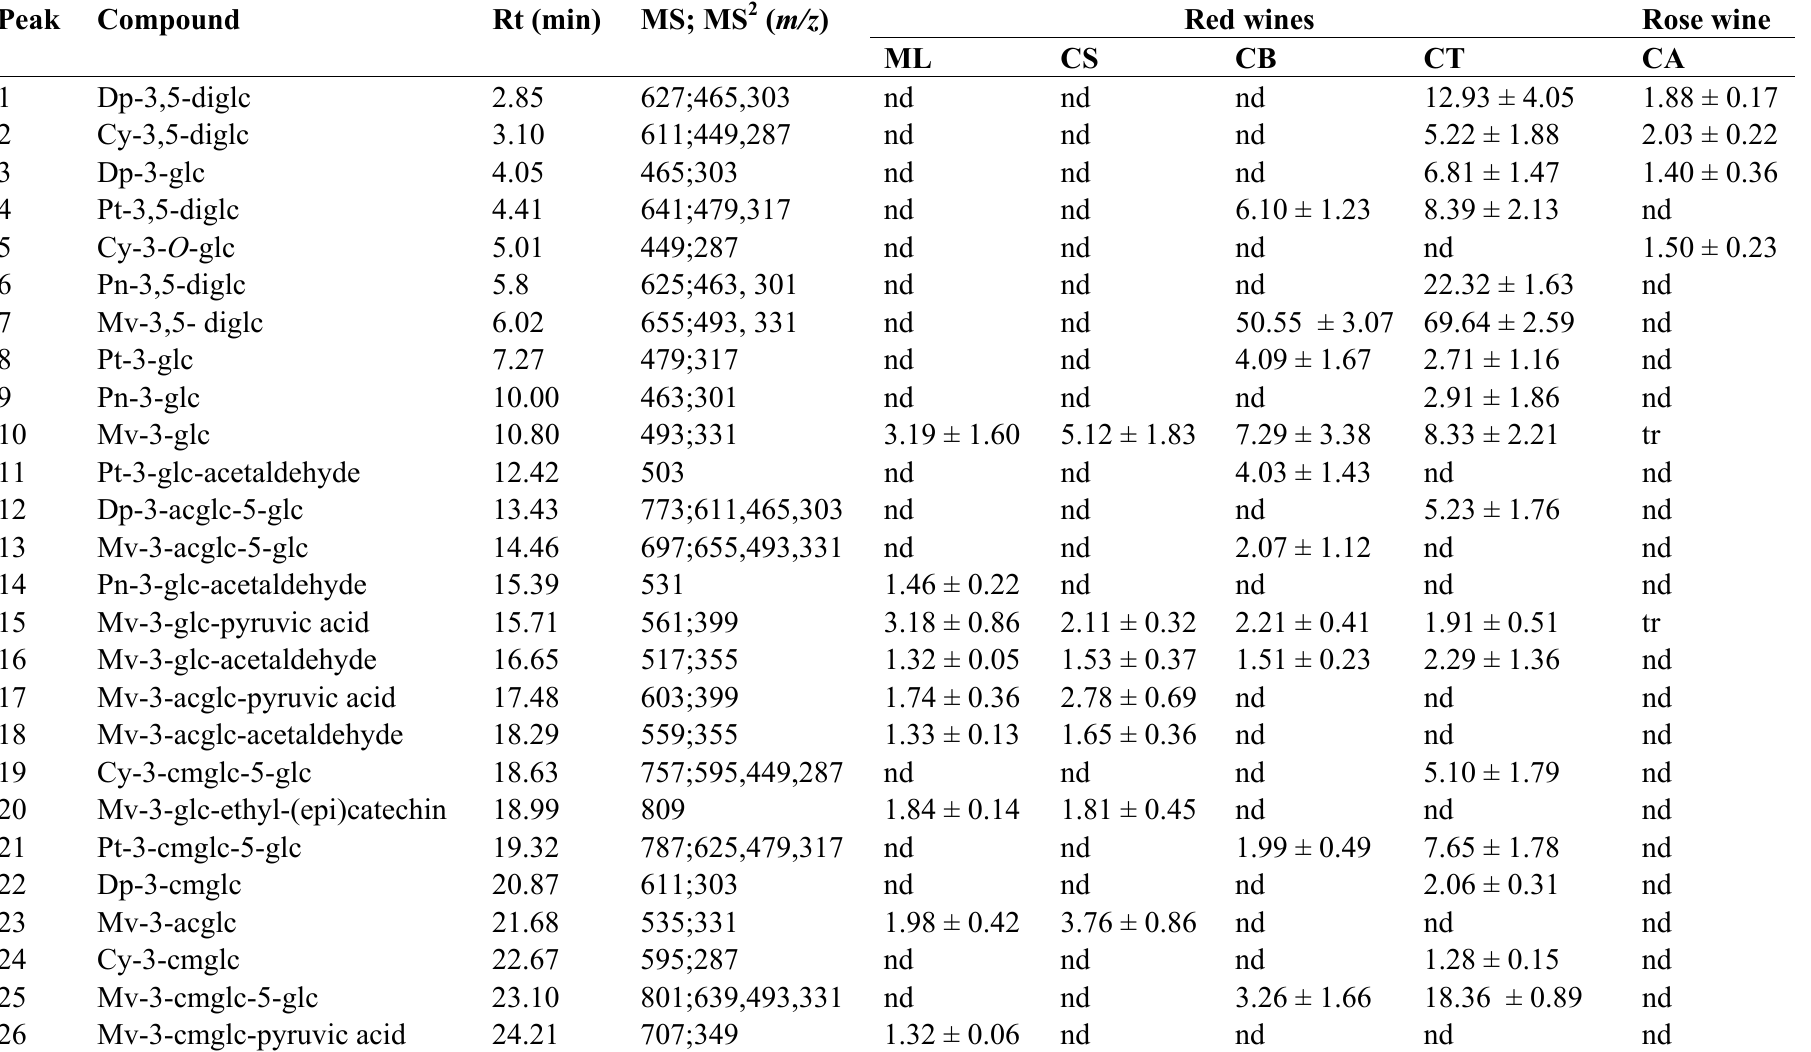
Table 3. Retention times, ESI-MS/MS m/z values (molecular ion (MS); product ions (MS 2 )) and concentrations of individual anthocyanins identified in the red and rose wines from different grape